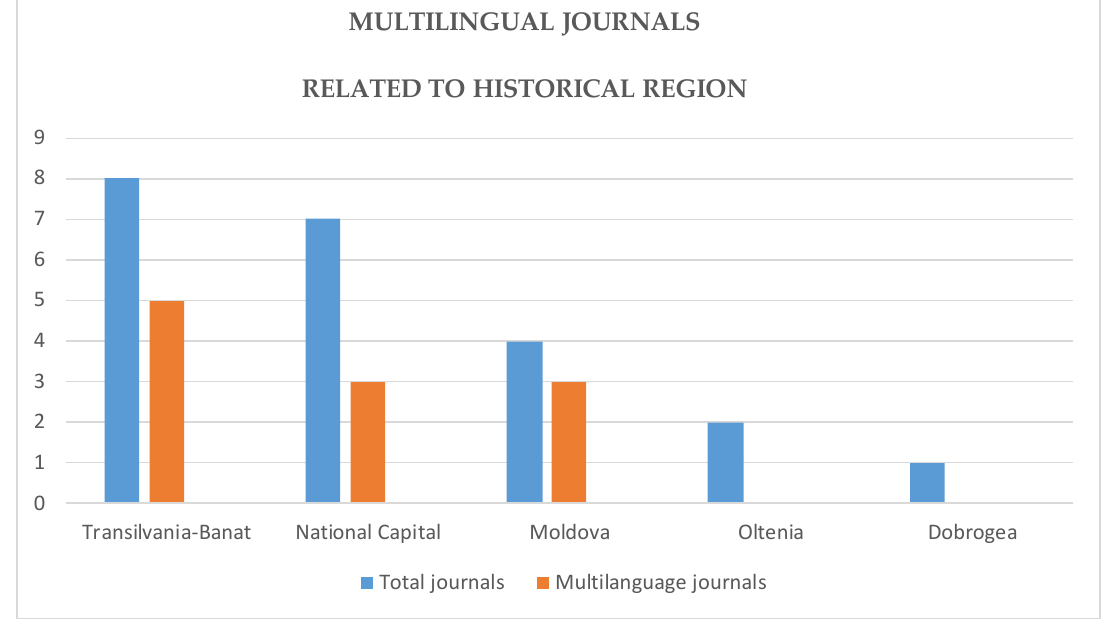
Figure 2. Linguistic preferences, by region.